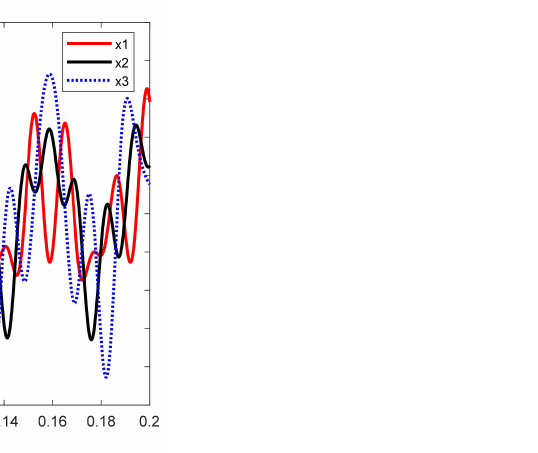
Figure 2. Vibration displacement response of a three-degree-of-freedom stiffness periodic time- varying system.